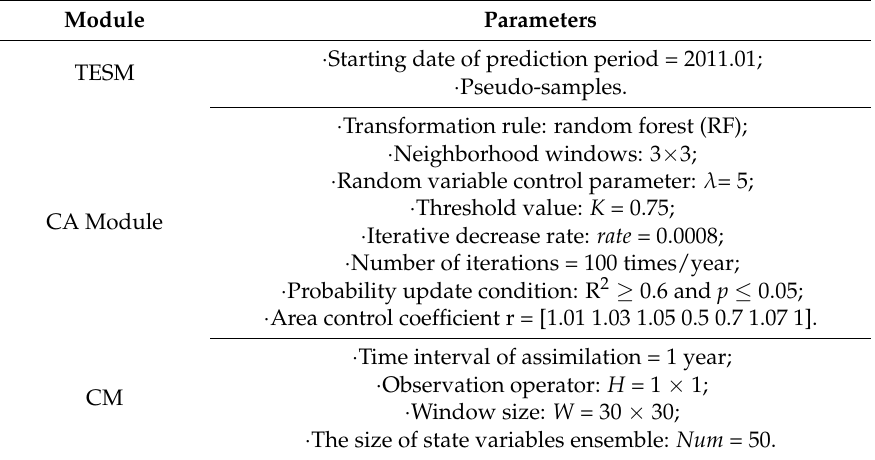
Table 3. Parameters used in the TDE-CA which were organized by different